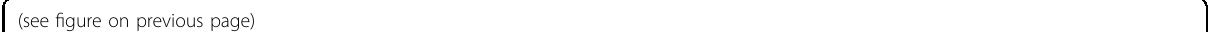
Fig. 1 Engineering of TaC9-ABE with high on-target activity and without detectable Cas9-dependent off-target activity. a The main components of TaC9-ABE and ABE7.10 vectors. b Schematic diagram of the base-editing principle of TaC9-ABE at the target and off-target sites. Yellow shape indicates the nCas9 (S. pyogenes Cas9 with a D10A mutation). Colored clusters indicate TALE recognition sites. The blue pliers ’ shape indicates the TadA wild-type and mutant dimer. Green dot and line indicate the on-target SgRNA sites. The red indicates the off-target sites. c The base-editing ef fi ciency under different combinations of nCas9, adenosine deaminase, and TALE on human AAVS1 site. The gray bars represent the editing ef fi ciency of a single component, and the uniform distance of the TALE component from the sgRNA site is 6 bp. The blue shows that the distance between TALE and sgRNA targets is 6 bp, and the pink represents 10 bp. d – g The base-editing ef fi ciency of the TaC9-ABE system with a different target distance of TALEs and SgRNAs at AAVS1 ( d ) and HEK2 ( f ). Comparison of the base-editing ef fi ciency of TaC9-ABE and ABE7.10 at AAVS1 site1 ( e ), HEK2 ( g ) in HEK293T cells ( n = 3, means ± sem). h Representative Sanger sequencing chromatograms at endogenous OTC-1 and DMD loci from rabbit embryos. Red arrow: substituted nucleotide; black arrow: the gRNA direction; red letter: pathogenic mutation sites; WT: wild- type. The relevant codon identities at the target site are presented on the left of the DNA sequence. i The comparison of TaC9-ABE and ABE7.10 for the base-editing ef fi ciency at Cas9-dependent off-target sites. Red letter indicates the off-target mismatch position. The blue shading indicates off- target editing frequencies. C9DOT: Cas9-dependent off-target. The average editing percentage derived from three independent experiments at the same site is